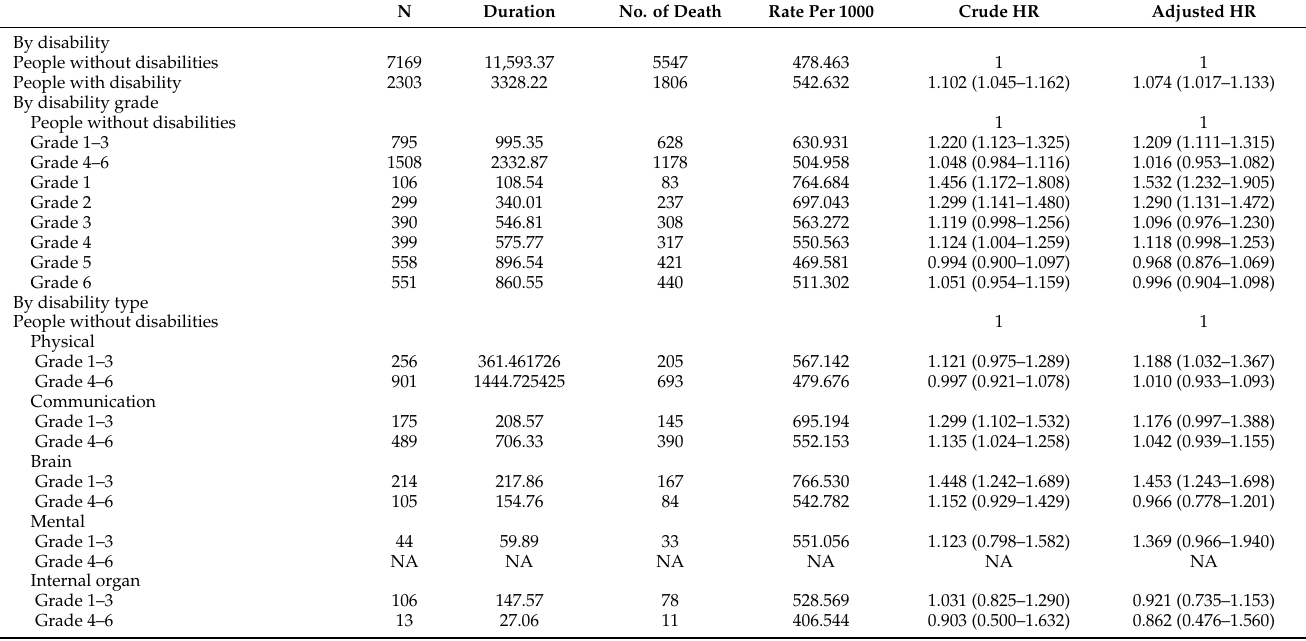
Table 6. Cancer-specific mortality in male patients diagnosed with bile duct cancer.